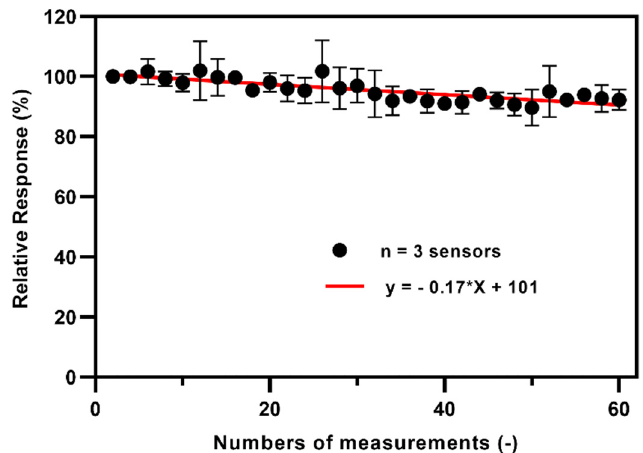
Figure 6. Operational stability of the TEMPO-CNC glucose sensors over 30 repeated measurements in 1 mM glucose solution in phosphate buffer. The graph depicts the average values of three individual sensors (mean ± standard deviation); the red linear fit indicates the loss in measured current over the 30 cycles (total of 6 h of measurement). The average remaining activity of the TEMPO-CNC glucose sensor after 30 measurements was 92.3% of the initial current.